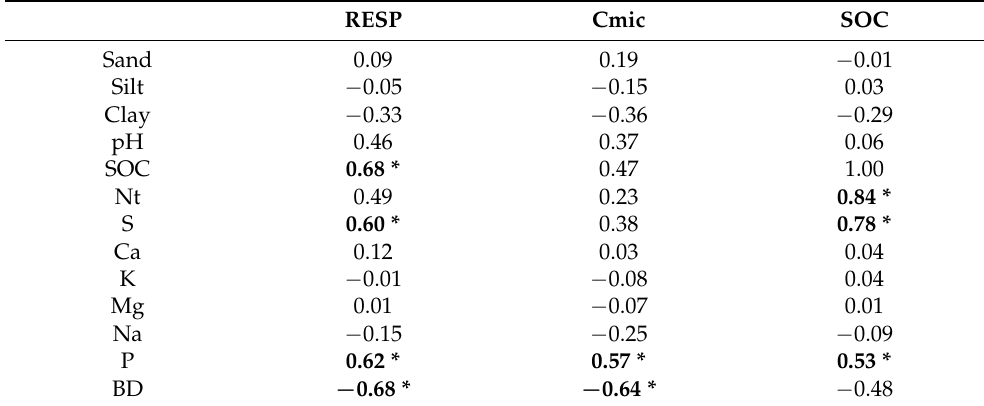
Table 4. Spearman’s correlation coefficient (r) between RESP, Cmic, SOC and studied physicochemical soil properties in 0–5 cm mineral horizons in the studied post-fire